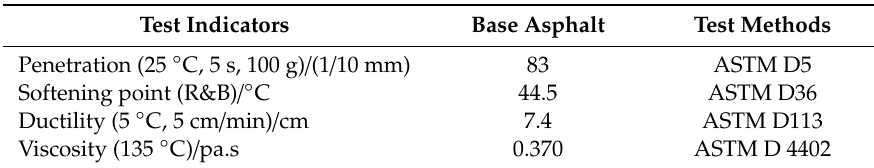
Table 1. Properties of asphalt